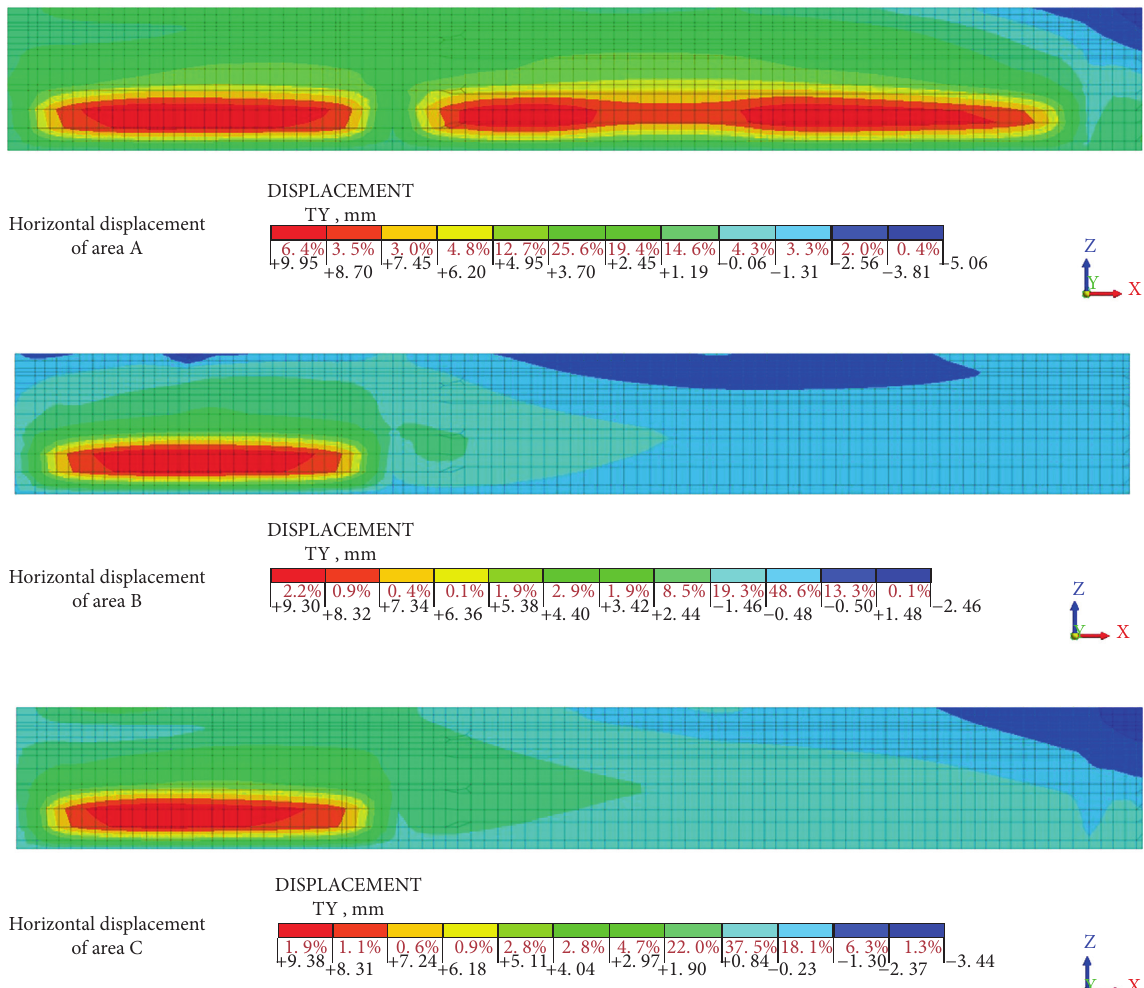
Figure 7: Deformation cloud diagram of the horizontal deformation of the common diaphragm wall in the east-west direction after excavating each partition.